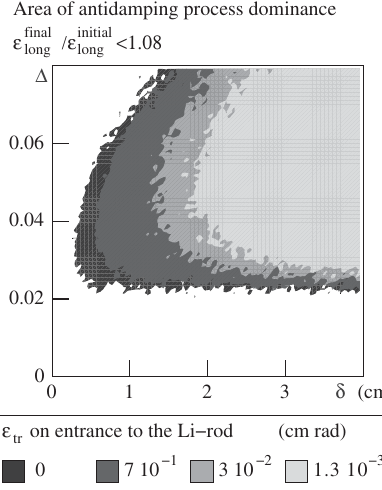
FIG. 8. The region of longitudinal parameters (cid:5) and (cid:1) in which the antidamping process dominates over the fluctuation of ion- ization losses (in other words, the region where the growth of the =" ini ) is below a preassigned value longitudinal emittance ( " fin long long defined from the asymptotics) after passage through one lithium rod for different values of the initial transverse